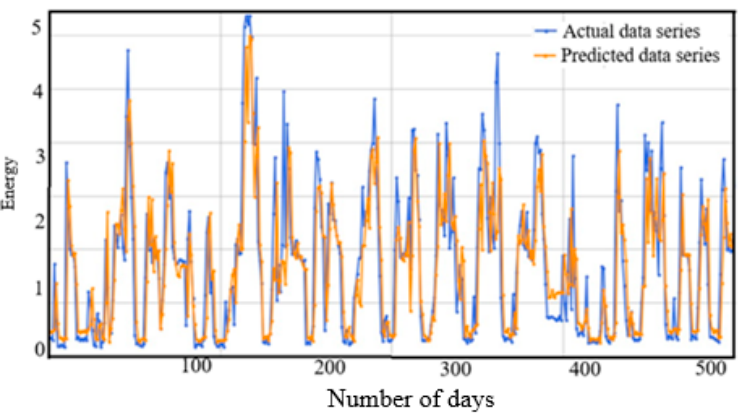
Figure 13. Prediction performance of the proposed model for the IHEPC dataset.